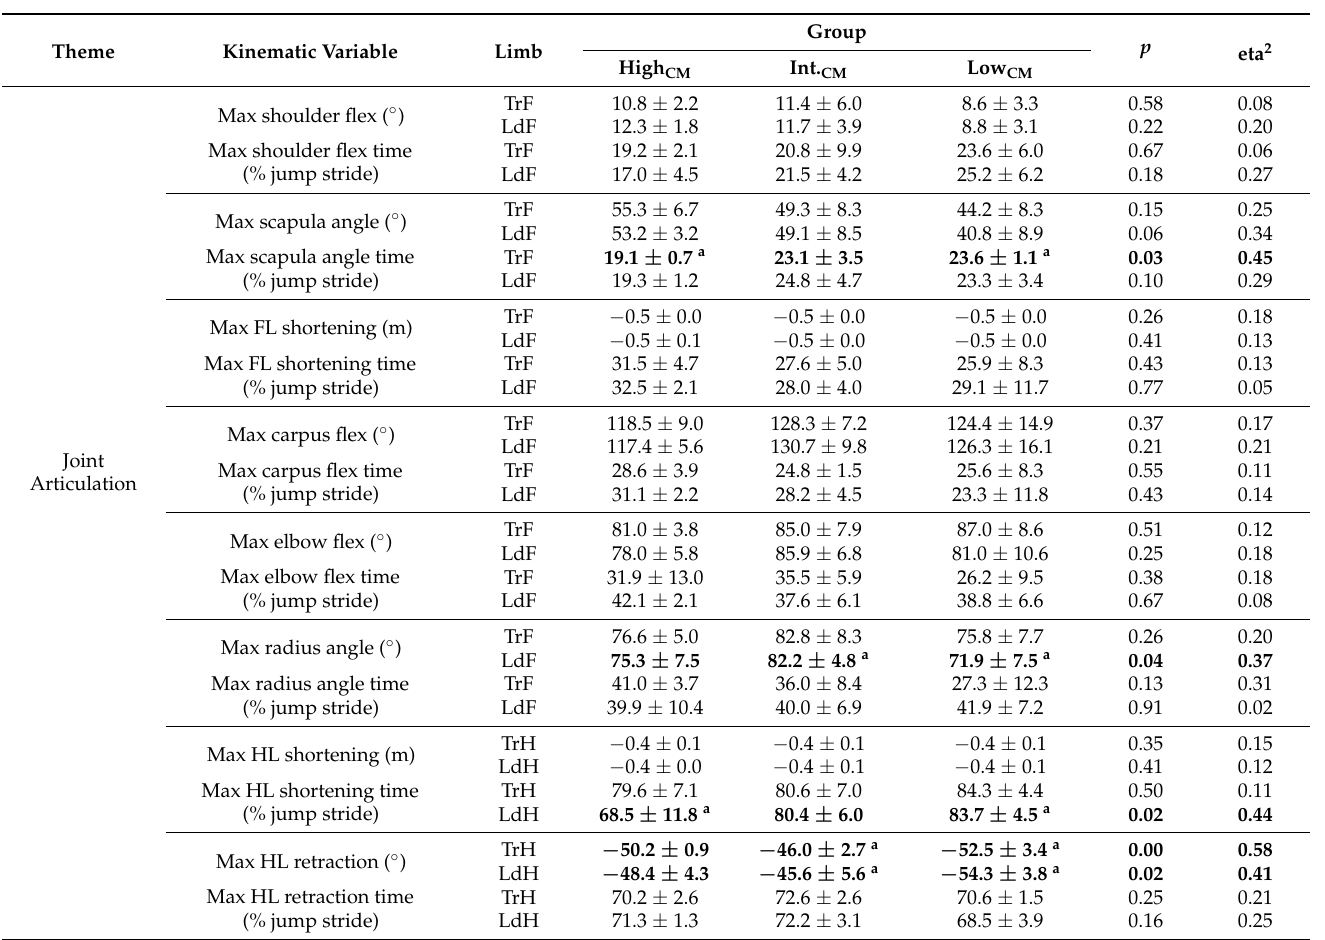
Table 1. Descriptive statistics (mean ± standard deviation) for kinematic variables within each subgroup of horses. Between- group differences are presented for each variable as p -values and effect sizes (eta 2 ). Within each row, significant main effects ( p < 0.05) for between-group differences are denoted by bold text and significant differences ( p < 0.05) between groups are represented by corresponding superscripts ( a–c ). Significant differences ( p < 0.05) between limbs are denoted by grey shaded